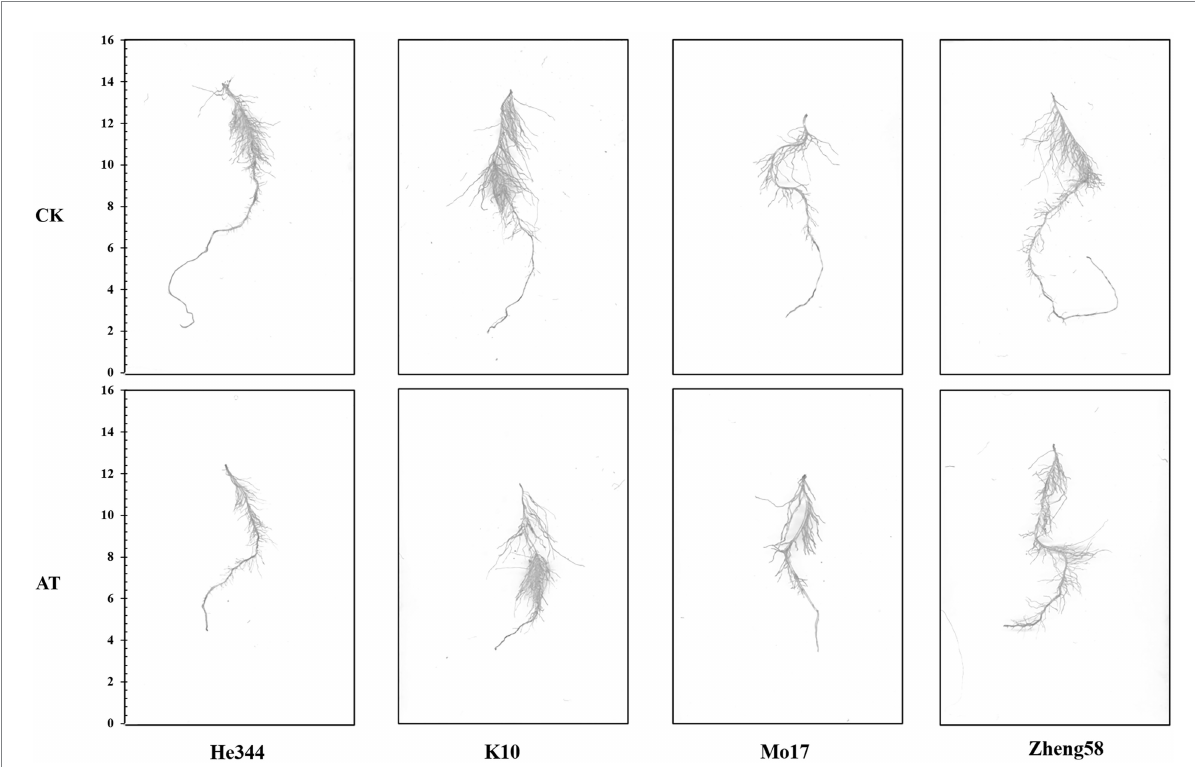
FIGURE 1 Morphological change in maize under control (CK) and alkaline (AT) treatment. Comparison of roots of maize inbred line He344; inbred line k10; inbred line Mo17; and inbred line Zheng58 under control and alkaline treatment for 10 days. The alkali-sensitive inbred lines Mo17 and He344 are from the Lancaster group, and the alkali-tolerant inbred lines Zheng58 and K10 are from the PA